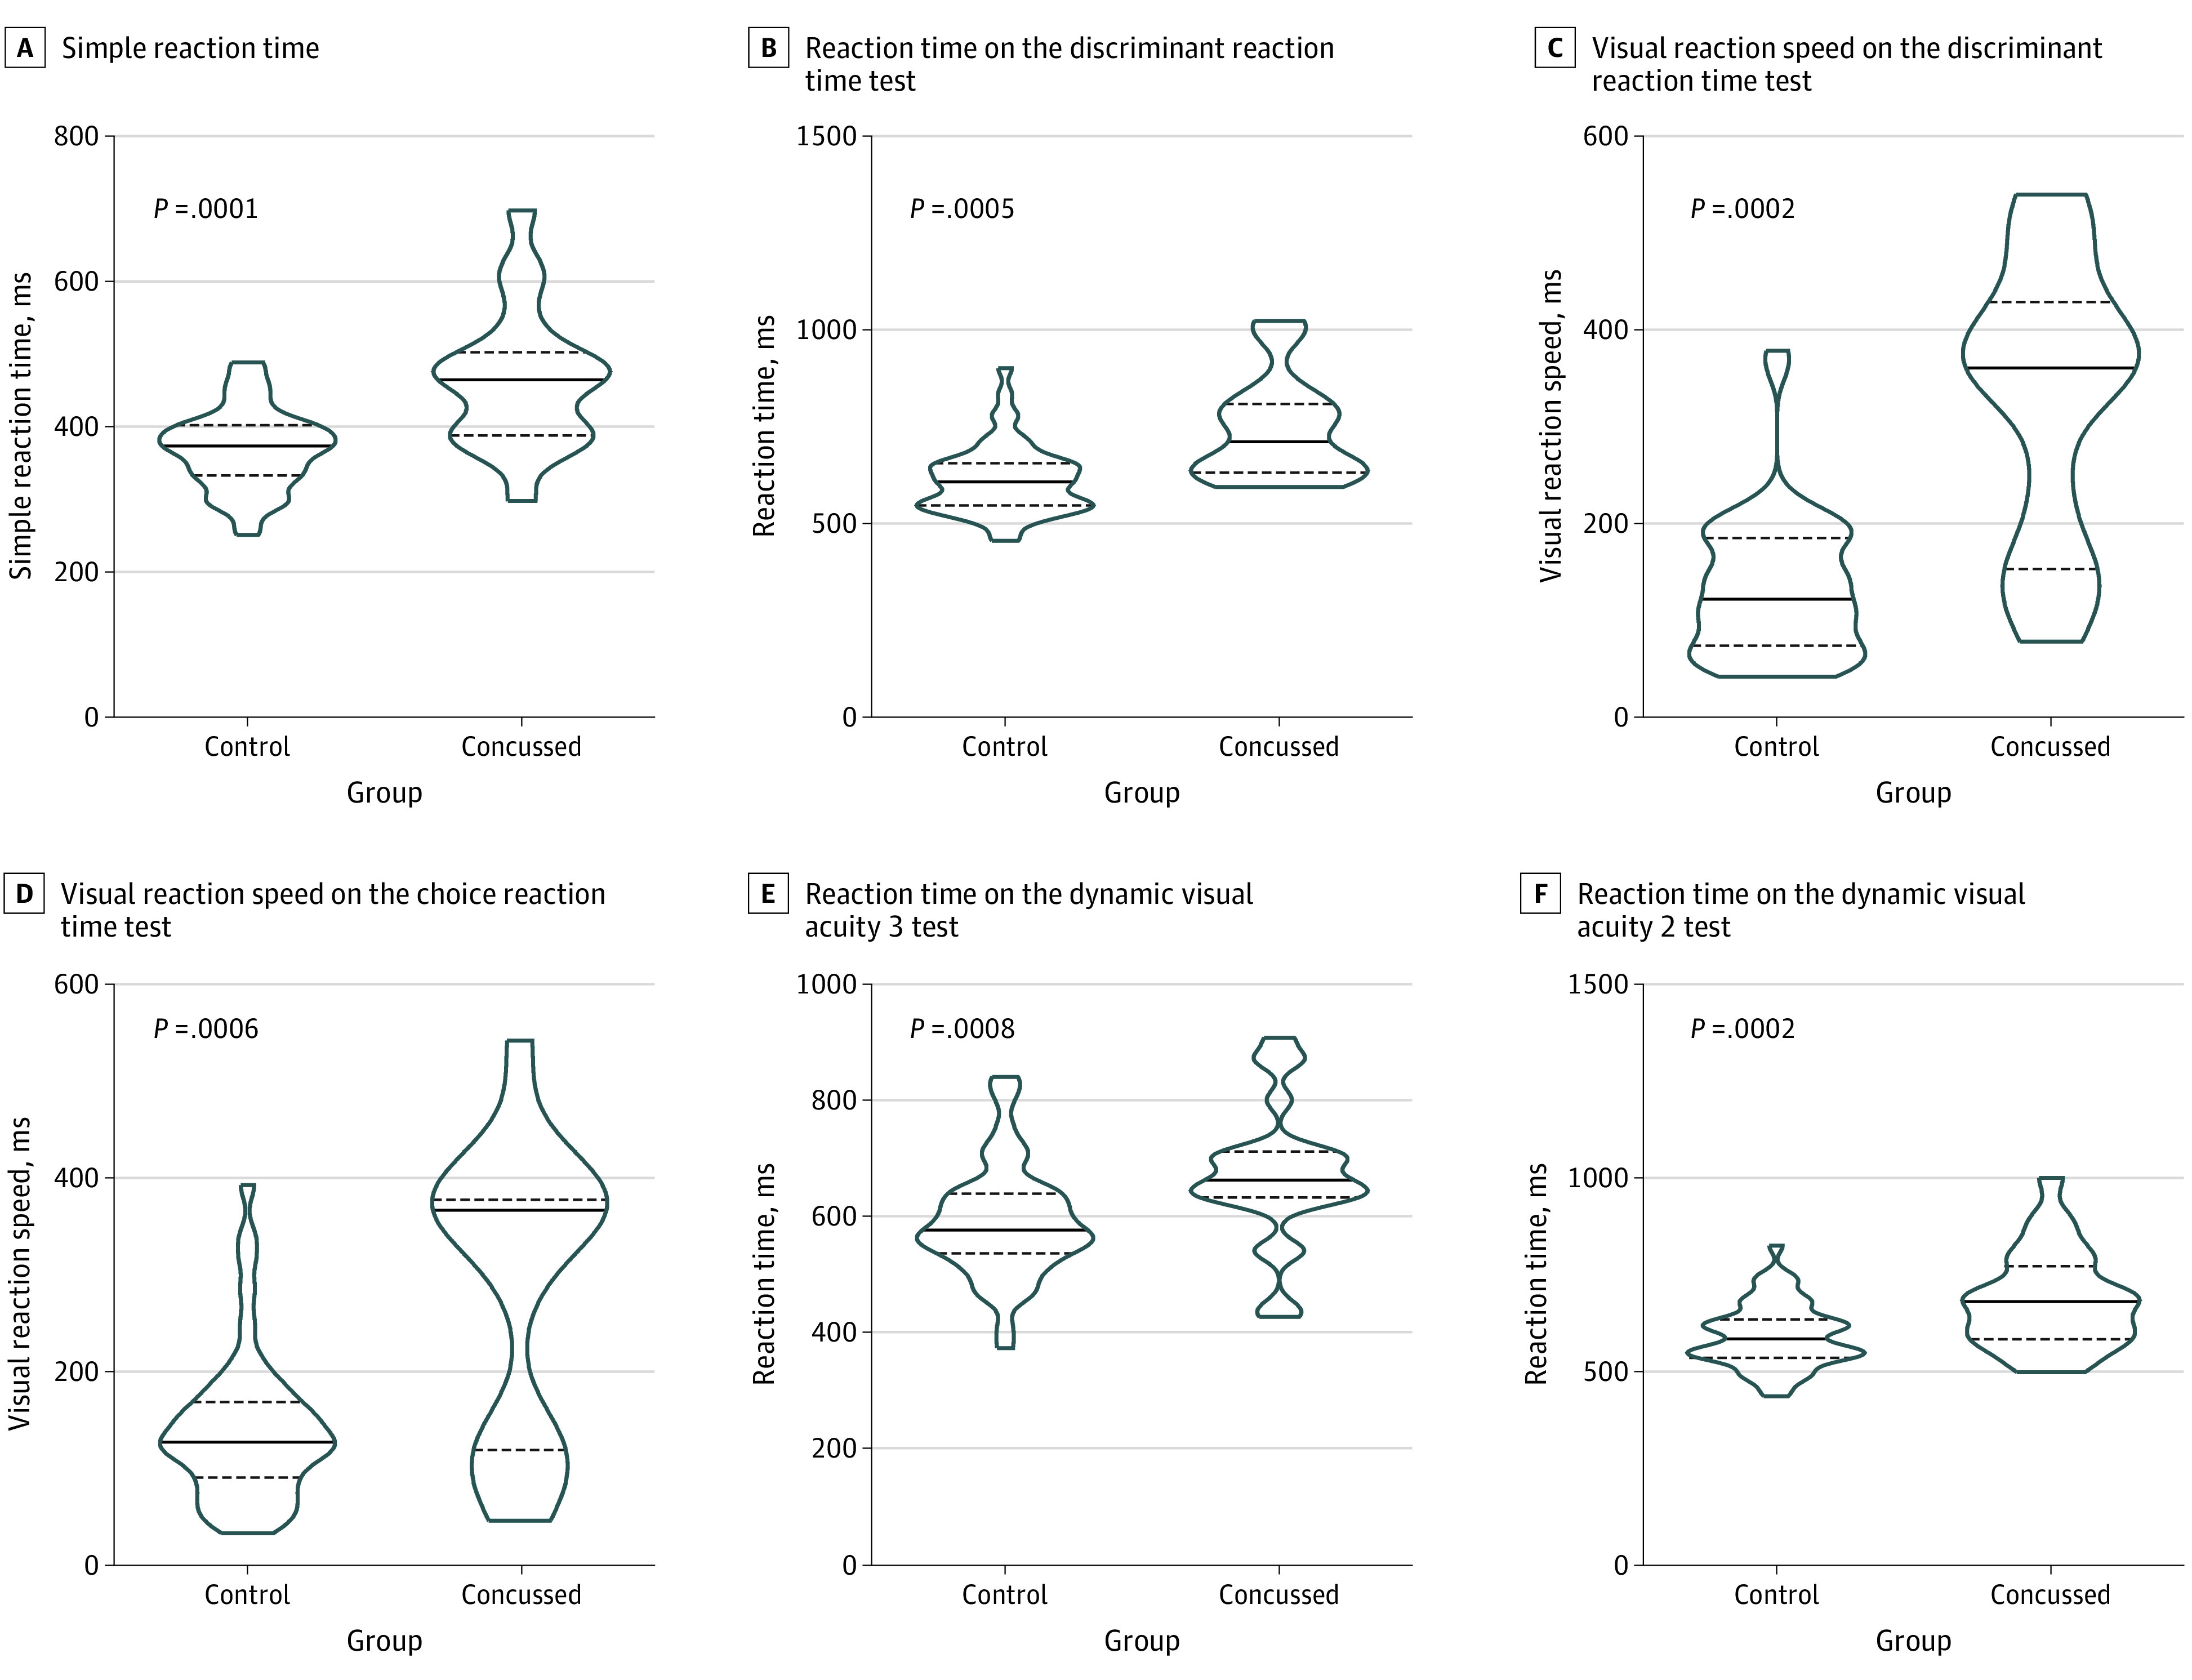
Comparison of Clinically Important Eye-Tracking Metrics in Concussed and Control AthletesTruncated violin plots displaying the rotated kernel density for each of the 6 clinically important eye tracking metrics in participants with and without concussion, compared using unpaired t test with a Bonferonni-corrected P < .0012. Solid line indicates median; dashed lines, interquartile range.